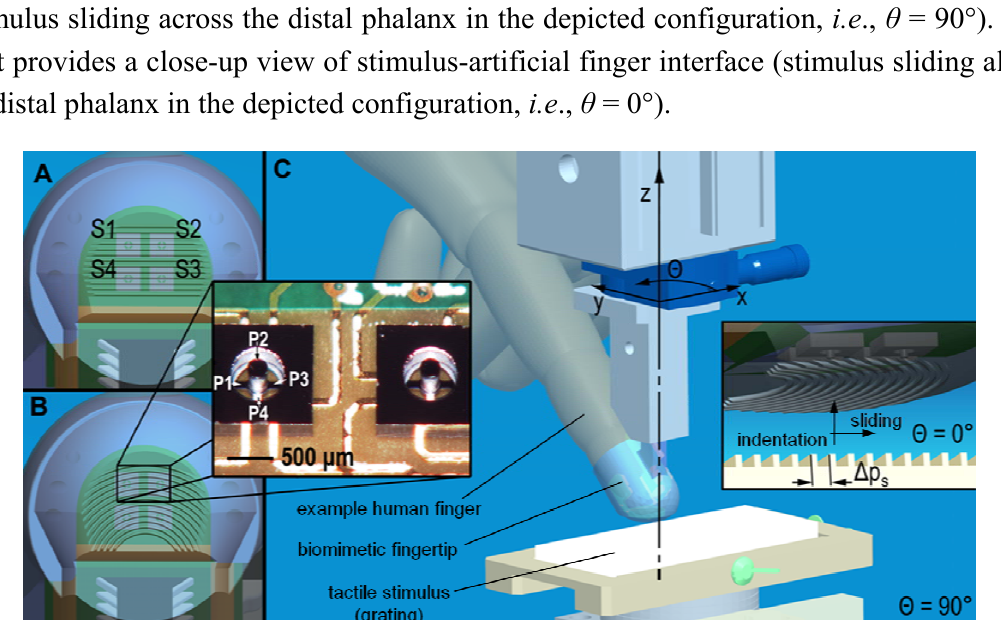
Figure 1. Design of the biomimetic fingertip integrating the rigid-flex board with 2 × 2 MEMS sensor array and readout electronics. Fingerprints embossed in the polymeric packaging had two curvatures. Panel A shows fingertip a design with straight